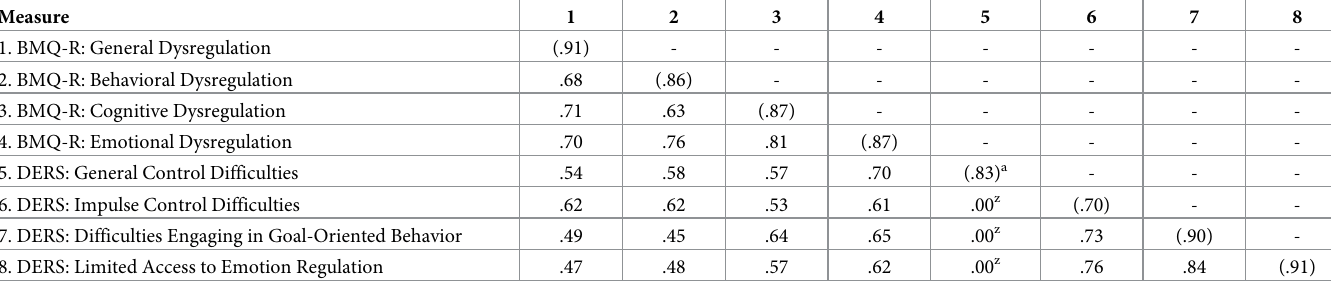
Table 8. Latent intercorrelations for misophonic dysregulation with convergent measures.